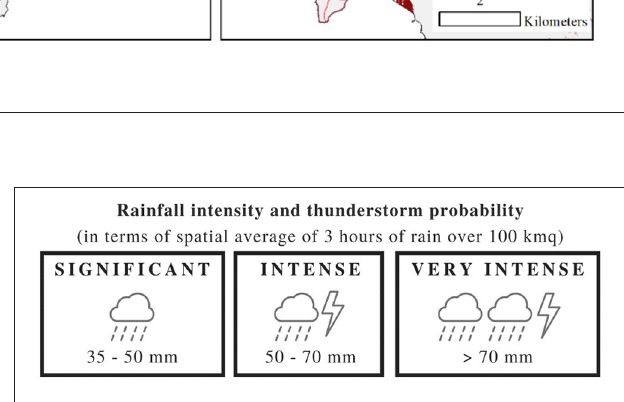
FIGURE 3 | Precipitation and thunderstorm classification according to ARPAL 6 (source: